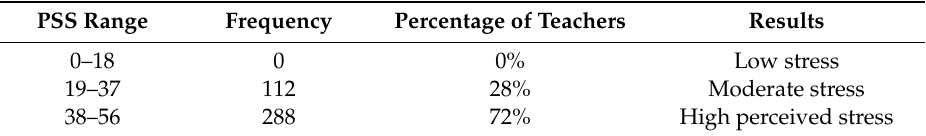
Table 14. PSS scoring.